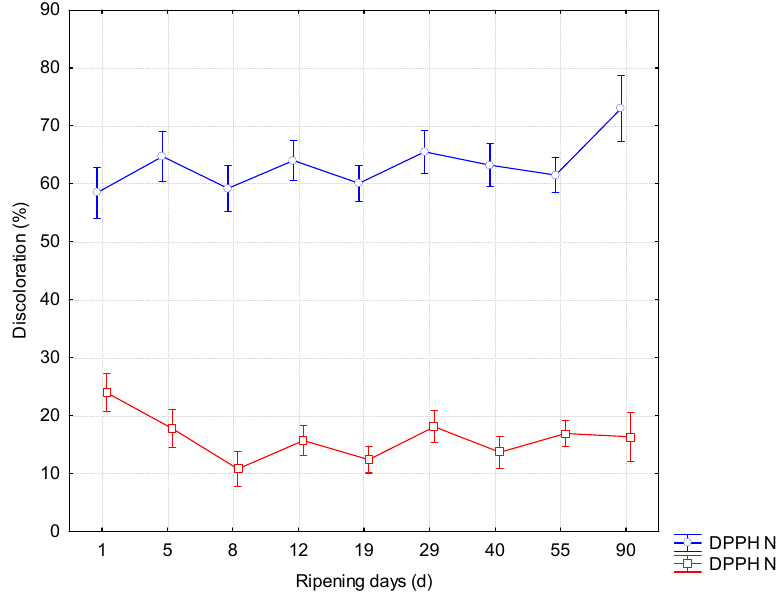
Figure 4. Evolution of DPPH discoloration percentage during the ripening process in both fractions.